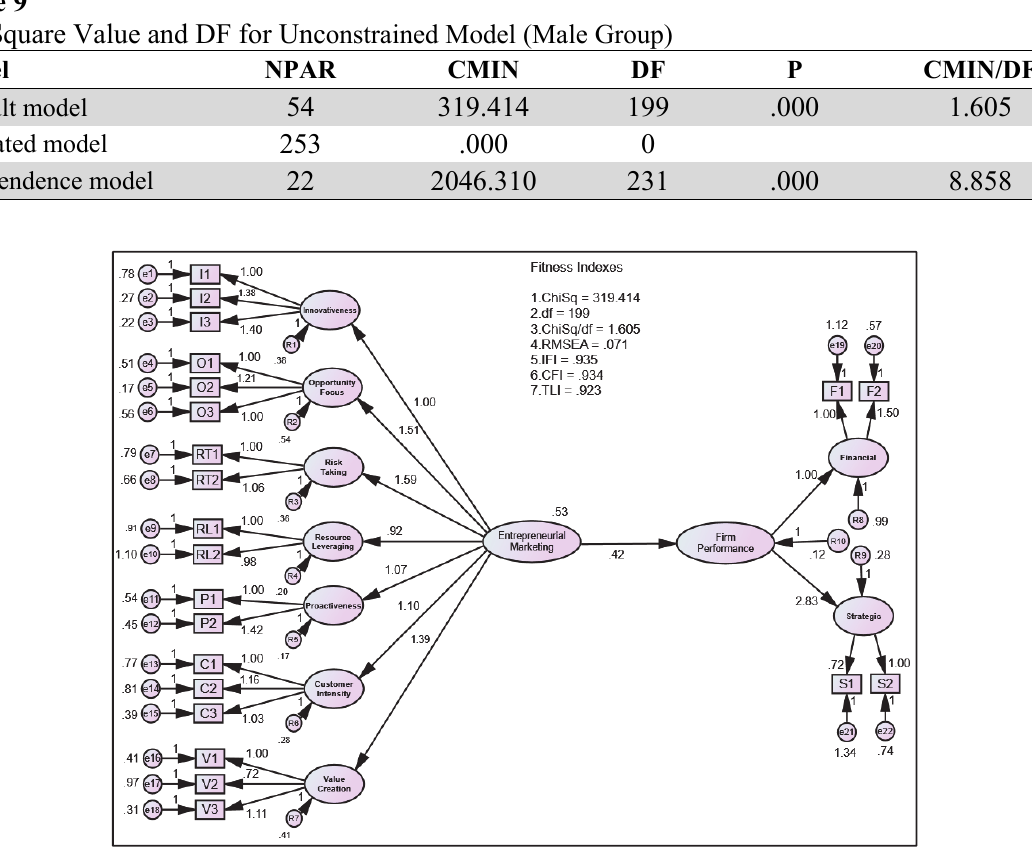
Fig. 6. Male Group: Unconstrained Model